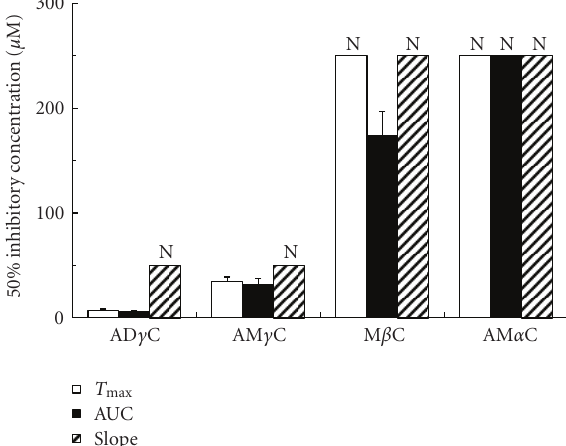
Figure 2: Concentrations of carbolines to produce 50% inhibition of the platelet aggregation responses ( T max , AUC, and slope) to collagen. N: Not inhibited by 50% at the indicated concentrations. Data are presented as mean ± SE ( n = 7).